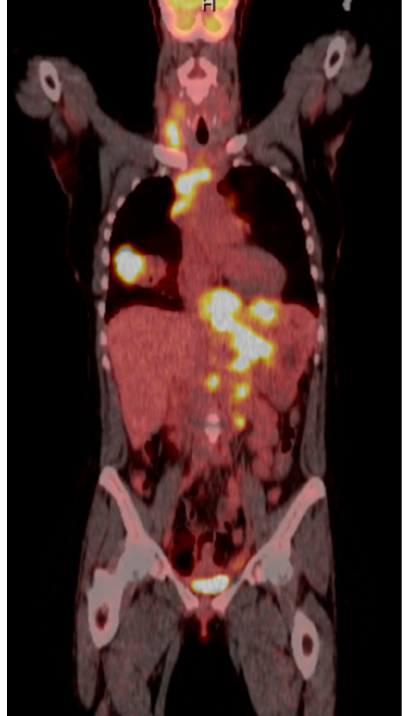
Diseases 2022 , 10 , x Figure 1. PET CT scan showing diffuse gastric wall thickening. Figure 1. PET CT scan showing diffuse gastric wall thickening.